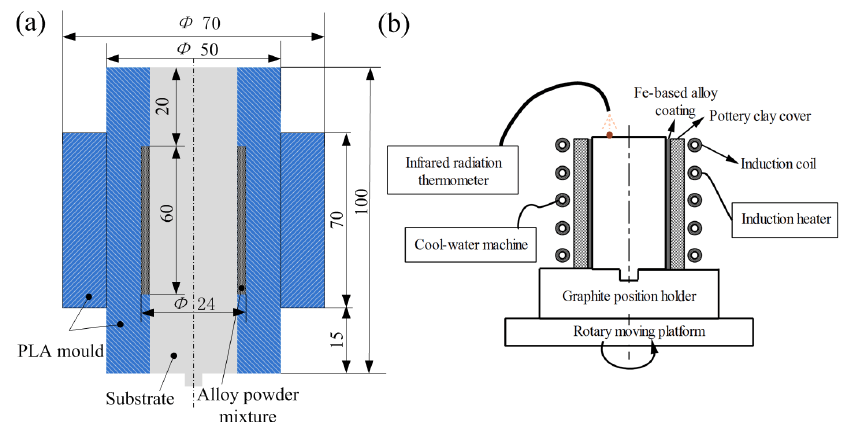
Figure 2. ( a ) Coating prepared mold and ( b ) schematic diagram of induction cladding device.